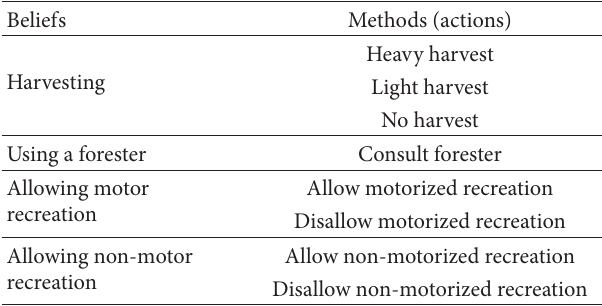
Table 3: The enabled beliefs and methods of FLAME. Beliefs were distributed on a scale of 0–2, from “do not believe in” to “fully believe in” taking a given action. Actions currently enabled in the model range from harvesting and consulting forester to implementing recreation access permission changes. These other beliefs and actions were grouped into a category of no